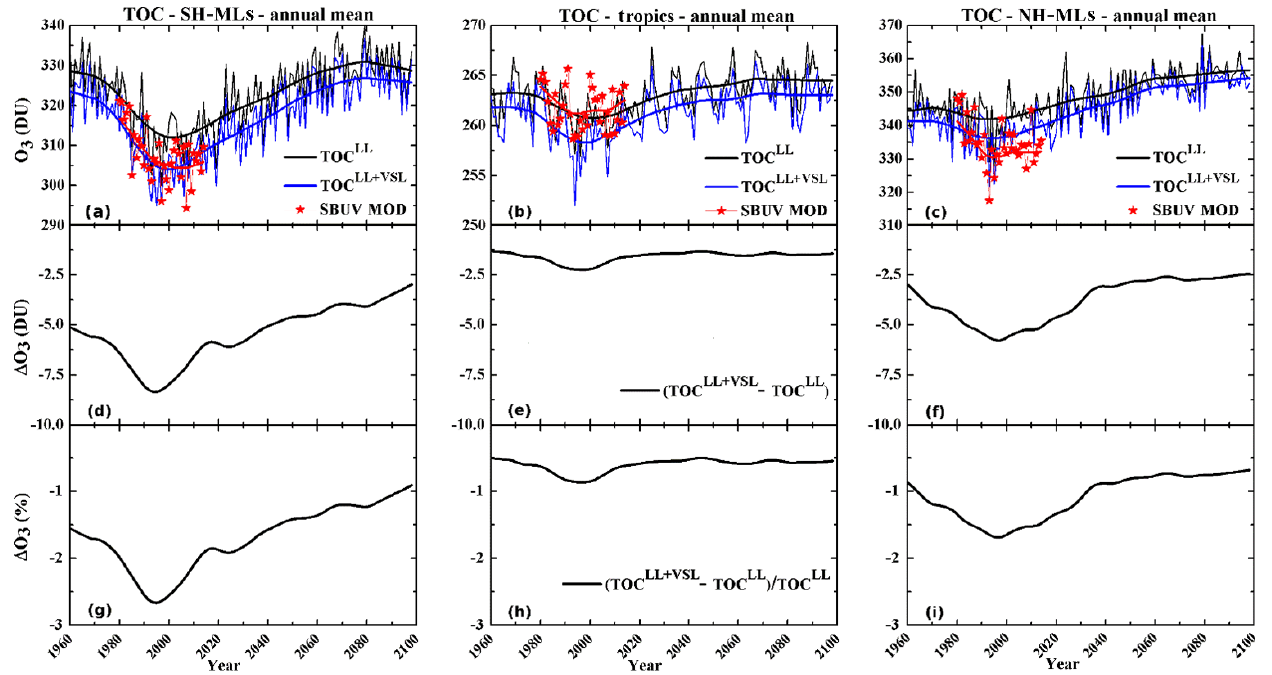
Figure 3. Temporal evolution of the annual mean total ozone column (TOC LL + VSL and TOC LL ) (a) at SH-MLs, (b) in the tropics, and (c) at NH-MLs as well as the corresponding absolute (DU; d–f ) and relative (%; g–i ) TOC difference ( (cid:49) TOC). TOC values of the mean ensemble (thin lines) and the smoothed time series via LOWESS filtering (0.2 fractions; thick lines) are shown in blue for TOC LL + VSL and black for TOC LL . The red lines and symbols show the observations from the Solar Backscatter Ultraviolet (SBUV) merged total ozone column data set (Frith et al., 2014, 2017) within the same spatial and temporal mask as the model